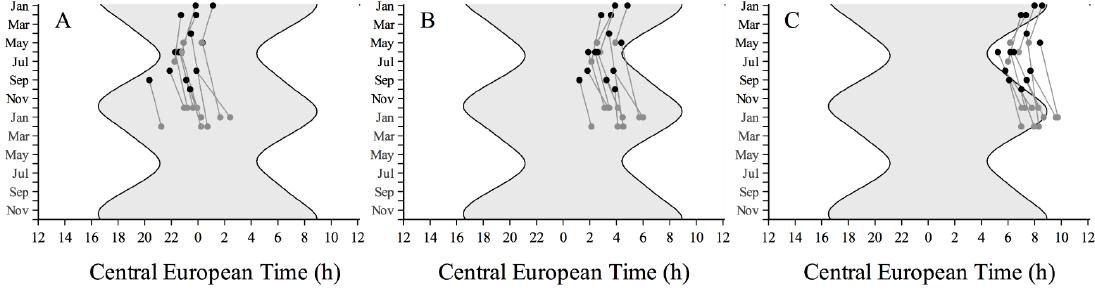
Figure 1. Sleep timing. Individual raw measurements of ( A ) sleep onset, ( B ) midsleep, and ( C ) sleep offset before (black circles) and after (grey circles) cataract surgery across the year as a function of Central European Time (CET). The grey area represents the night time.